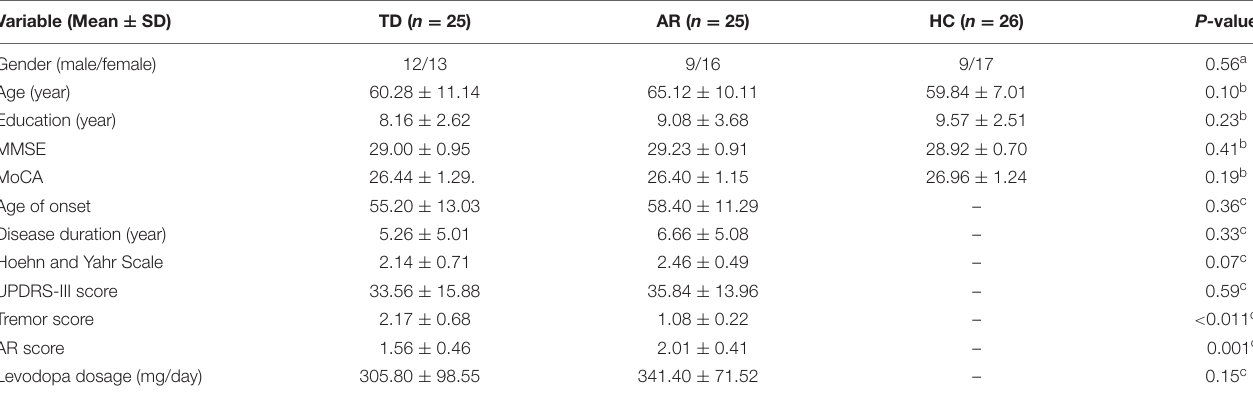
TABLE 1 | Demographic information and clinical characteristics of study subjects.